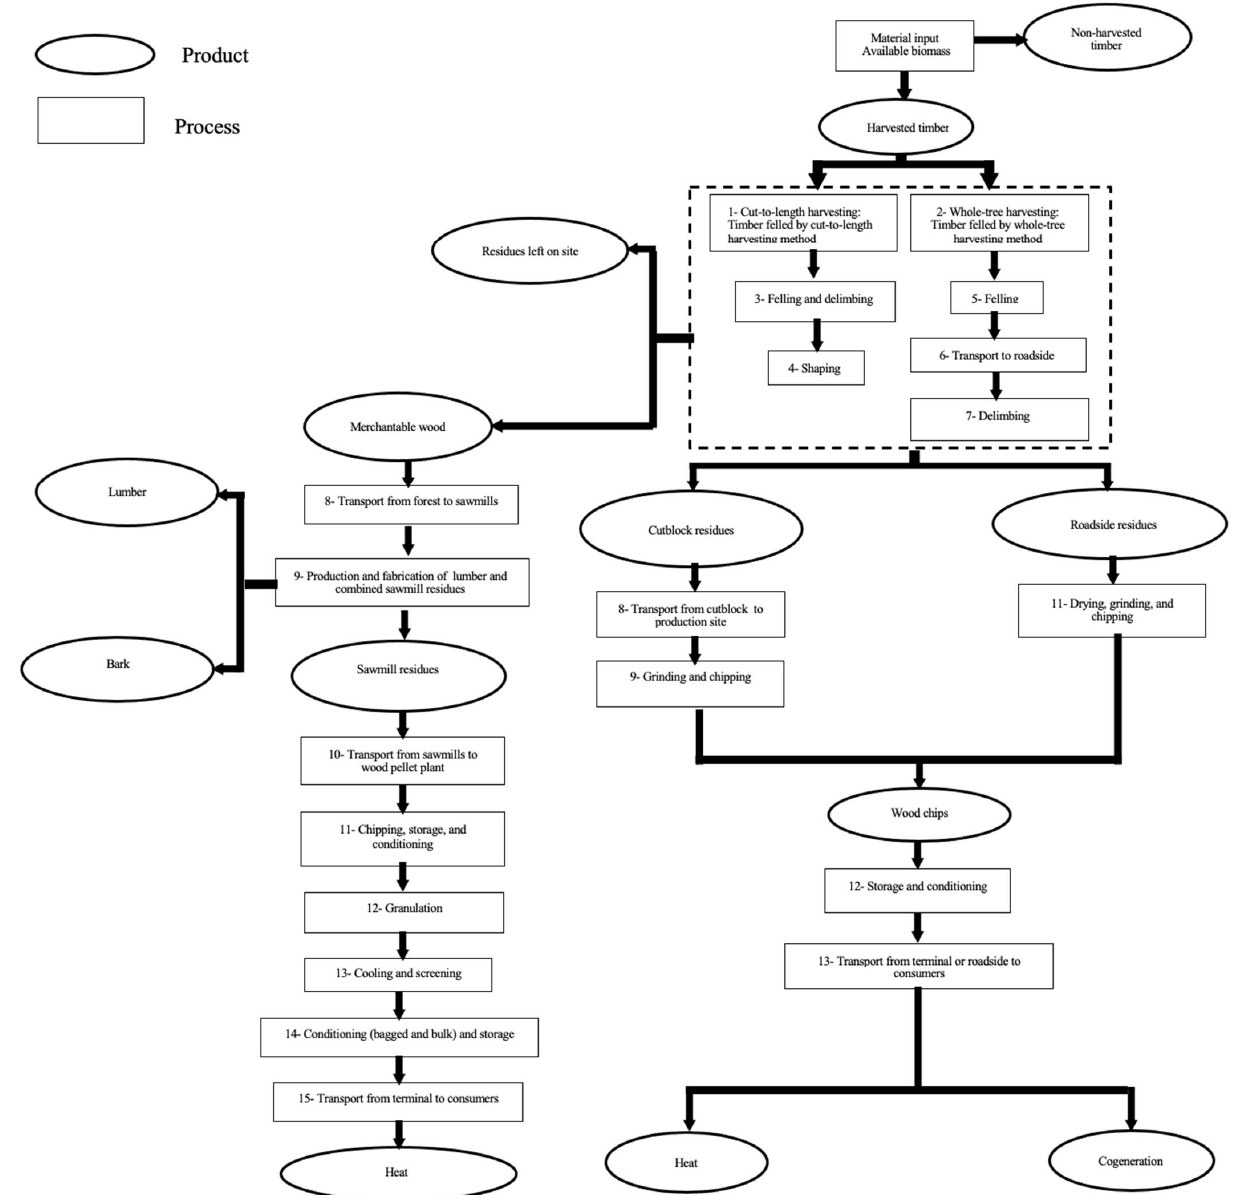
Figure 1. Simplified scheme of wood chip and wood pellet value chain topology in the Capitale- Nationale